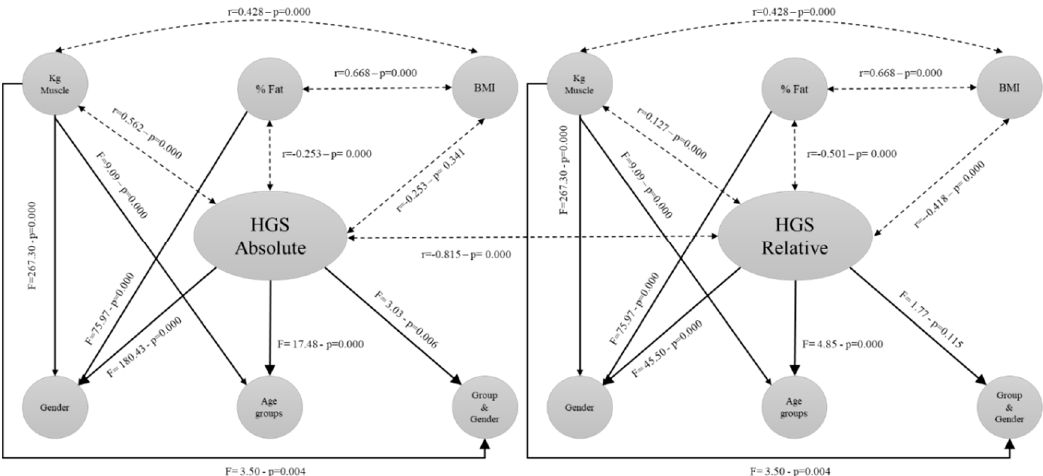
Figure 1. Correlations and mean di ff erences with the absolute and relative handgrip strength (HGS).